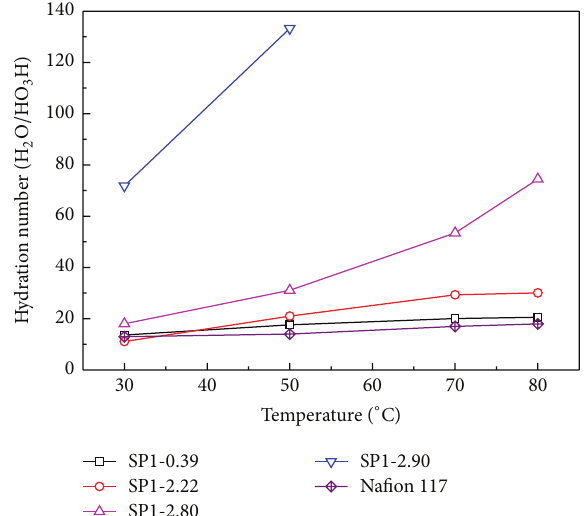
Figure 2: Thermogravimetric graph of P1 and SP1- 𝑋 .